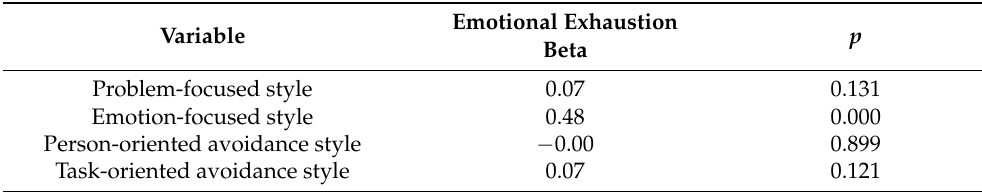
Table 4. Multiple regression model, the three coping styles as predictors to the explained variable of emotional exhaustion.